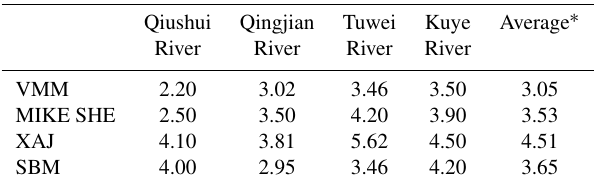
Table 4. Lag time of the peak flow in the four catchments in the four models. Values are in